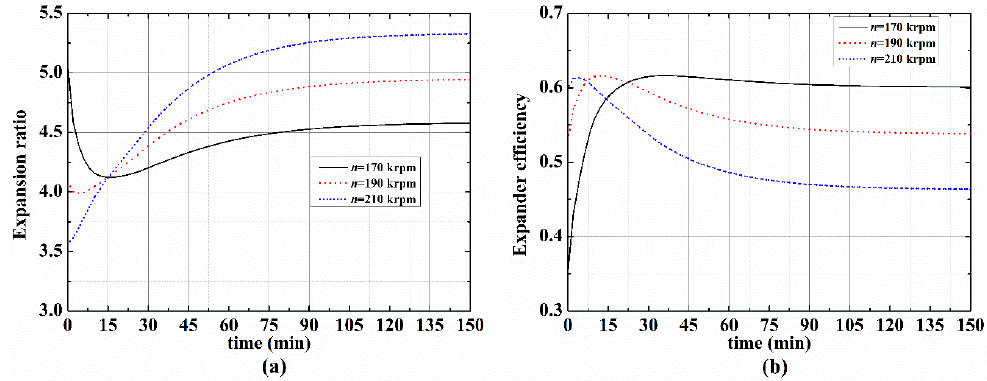
Figure 9. Dynamic expansion characteristics with a motor: ( a ) Expansion ratio; ( b ) expander efficiency.